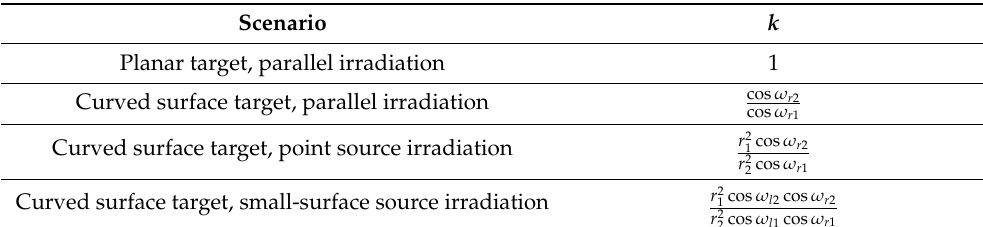
Table 1. Formulas of correction factor k . Scenario k Planar target, parallel